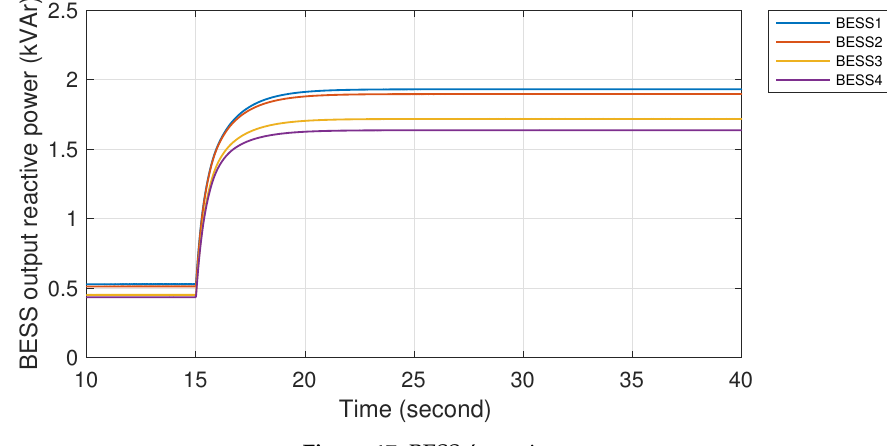
Figure 17. BESSs’ reactive powers.